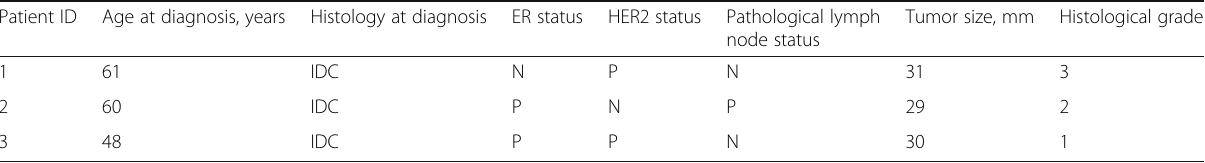
Table 1 Patient cilincal ad pathological charcteristics and details of sample collection Patient ID Age at diagnosis,